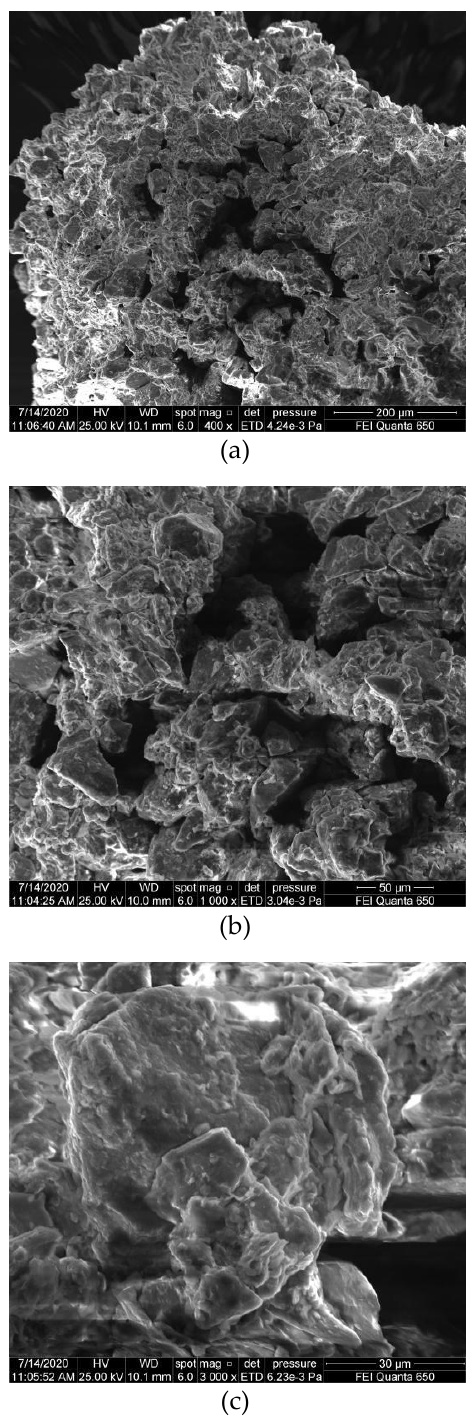
Figure 5. Micromorphology of Sample 0: ( a ) The magnification is 400; ( b ) The magnification is 1000; ( c ) The magnification is 3000.